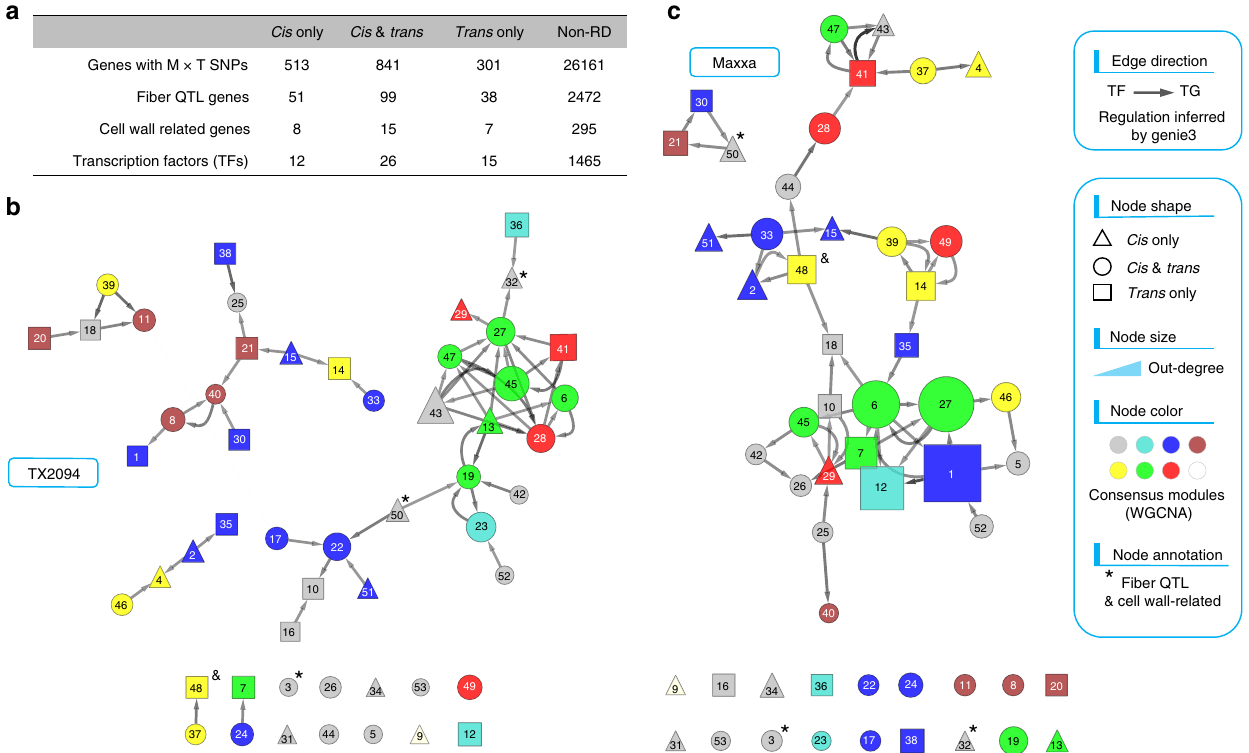
Fig. 5 Predicted GRNs of TX2094 and Maxxa fi bers. a Number of candidate genes within the fi ber QTL con fi dence intervals 28 , from a curated list of cell wall-related genes, and those annotated as TFs. For the total of 53 TFs that belong to the list of 1655 regulatory divergent (RD) genes (see annotation in Supplementary Data 2), a GRN was each inferred for TX2094 ( b ) and Maxxa ( c ) by Genie3 and visualized using Cytoscape. Edge direction represents the regulatory interaction from TF to target TG genes. Node shape represents the categorization of RD patterns. Node size is proportional to number of target genes (i.e., out-degree). Nodes color represents the membership of consensus co-expression gene modules inferred by WGCNA (see Methods and Supplementary Data 2). TFs marked by asterisk (node 3, 32, and 50) and and (48) were found within the con fi dence intervals of fi ber QTLs and related